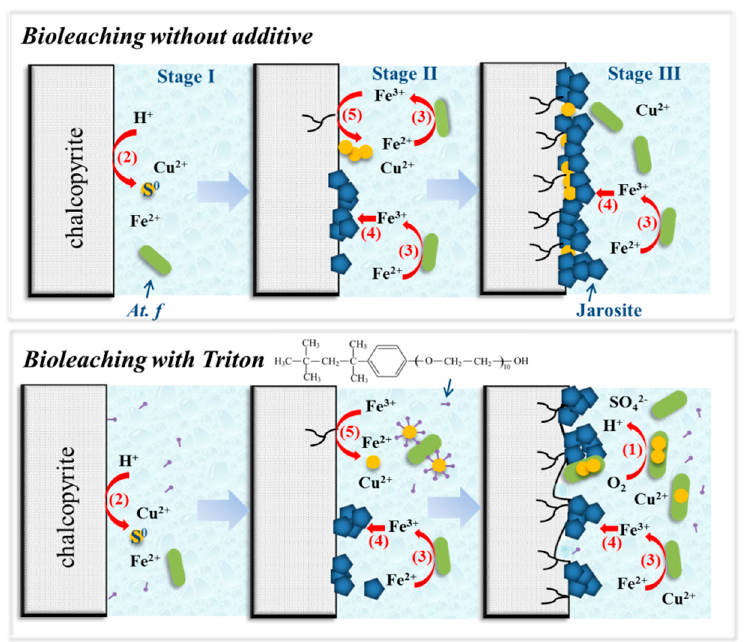
Figure 9. Proposed schematic diagram of enhancing chalcopyrite bioleaching under the induction of Triton X-100. The numbers (1)–(5) represent the Reactions (1)–(5).